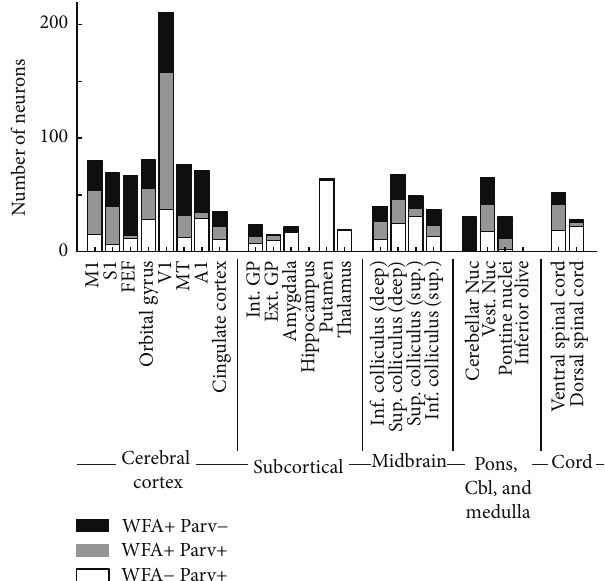
Figure 8: Relative frequencies of perineuronal net- and parvalbumin-positive cells in different areas of the brain of one male animal, age 5. Cells were counted in 0.92 mm 2 areas for each region listed. We tallied cells that stained positive for either PNNs (WFA+ Parv − , black) or parvalbumin alone (WFA − Parv+, white) as well as cells that stained for both markers (WFA+ Parv+, gray) separately. The regions examined were, from left to right, primary motor cortex (M1), primary somatosensory cortex (S1), frontal eye field (FEF), orbital gyrus, primary visual cortex (V1), mediotemporal cortex (MT), primary auditory cortex (A1), cingulate cortex, internal globus pallidus (int. GP), external globus pallidus (ext. GP), amygdala, hippocampus, putamen, thalamus, deep inferior colliculus, deep superior colliculus, superficial superior colliculus, superficial inferior colliculus, cerebellar nuclei (Nuc), vestibular nuclei (Vest. Nuc), pontine nuclei, inferior olive (IO), ventral (V) spinal cord, and dorsal (D) spinal cord.